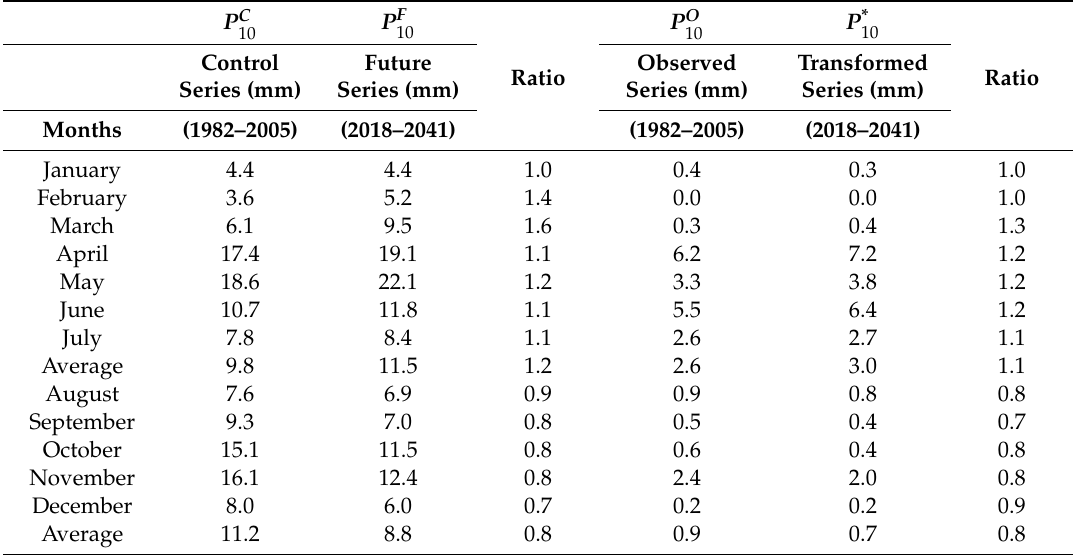
Table 6. Monthly summary of 10% quantiles and quantile ratios averaged for all stations.